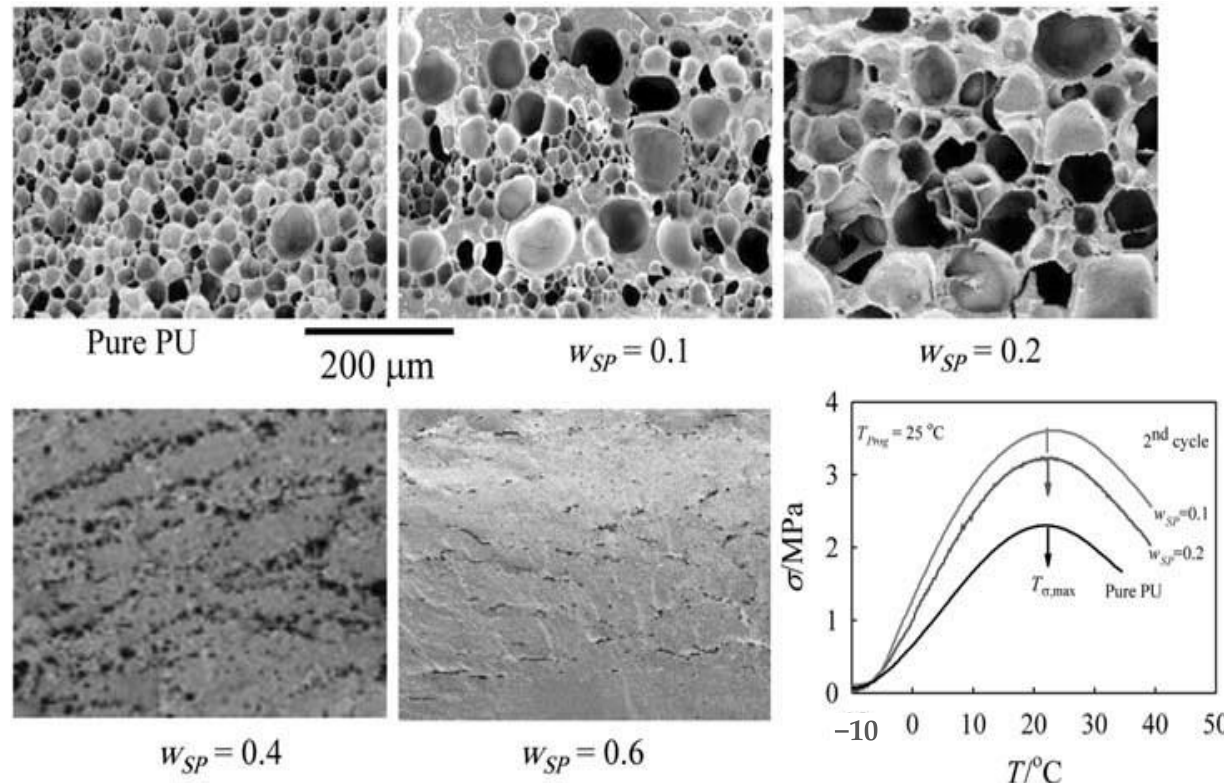
Figure 7. SEM micrographs for the porous structure of PU/SP blends of different concentrations that were generated using scCO 2 technique at 35 °C foaming temperature, 100 bar, and 30 min saturation time. Temperature dependence of stress for the thermomechanical cycle under constant strain condition for PU/SP blends of different concentrations. The measurements were carried out at T prog = 25 °C, ε m = 100%, T low = −10 °C, and T high = 50 °C. The arrows denoted the values of T σ, max for each composition (reproduced with permission from [85]).